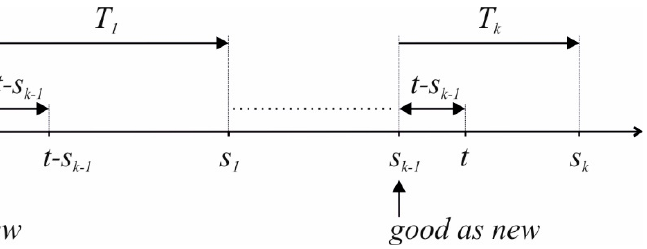
Figure 3. The value of the unavailability function u k ( t ) in the k -th renewal cycle for t ∈ ( s k − 1 , s k (cid:105) is the same as the value of the unavailability function u 1 at the time t − s k − 1